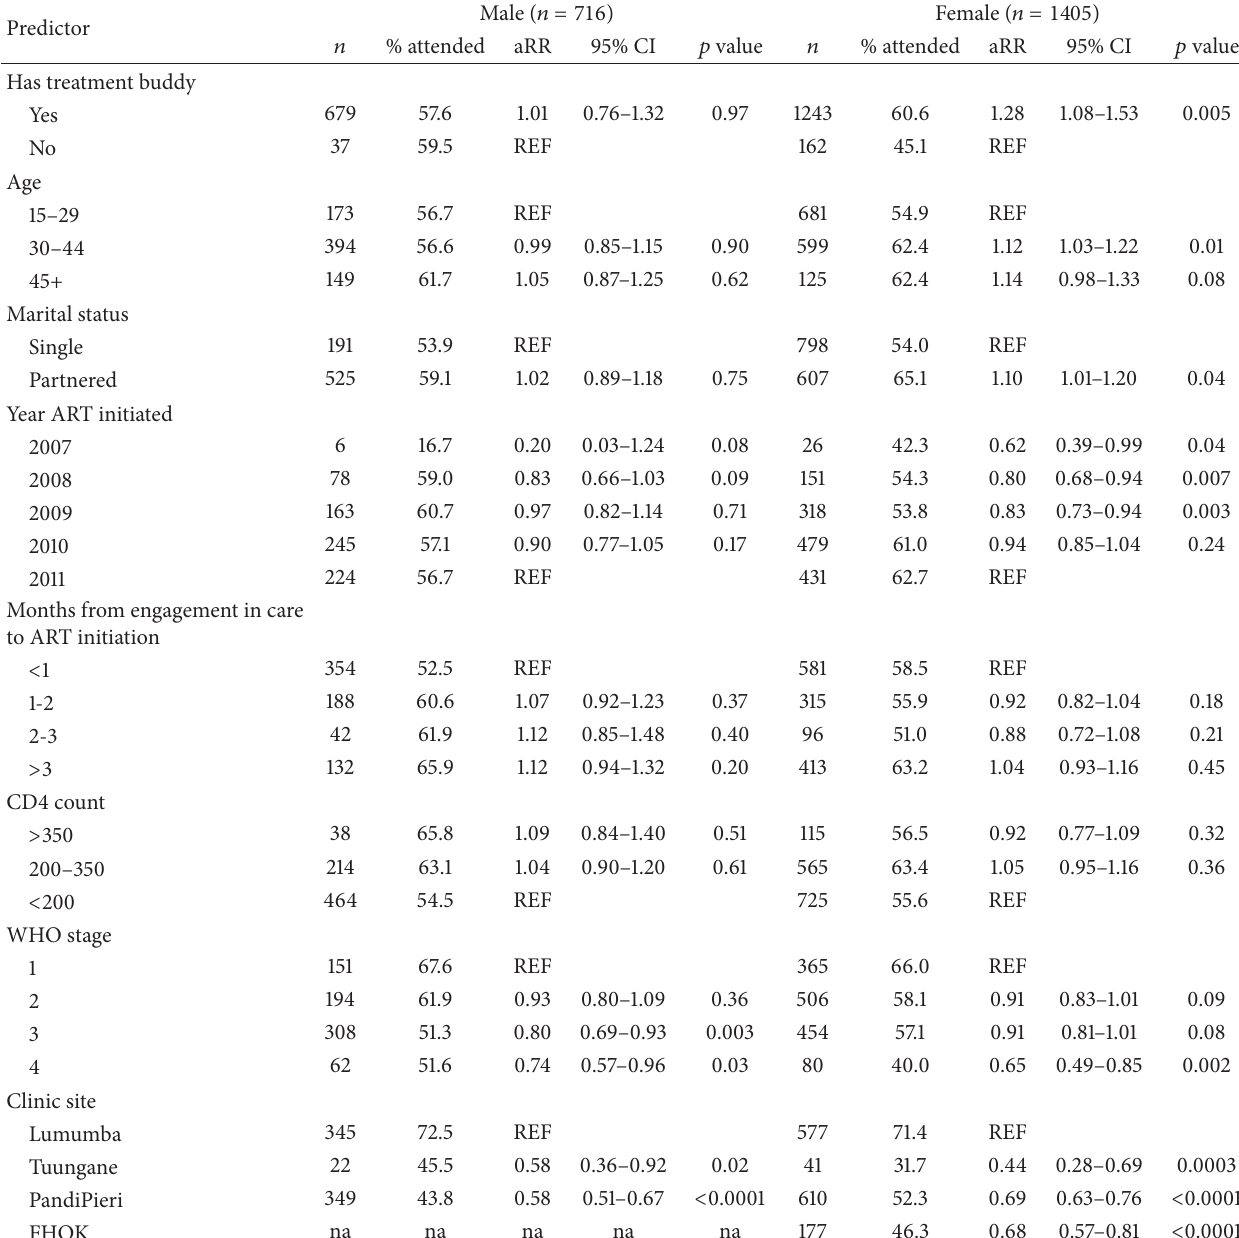
Table 3: Adjusted relative risks for factors associated with clinic attendance during the first six months on ART, by gender. Predictor